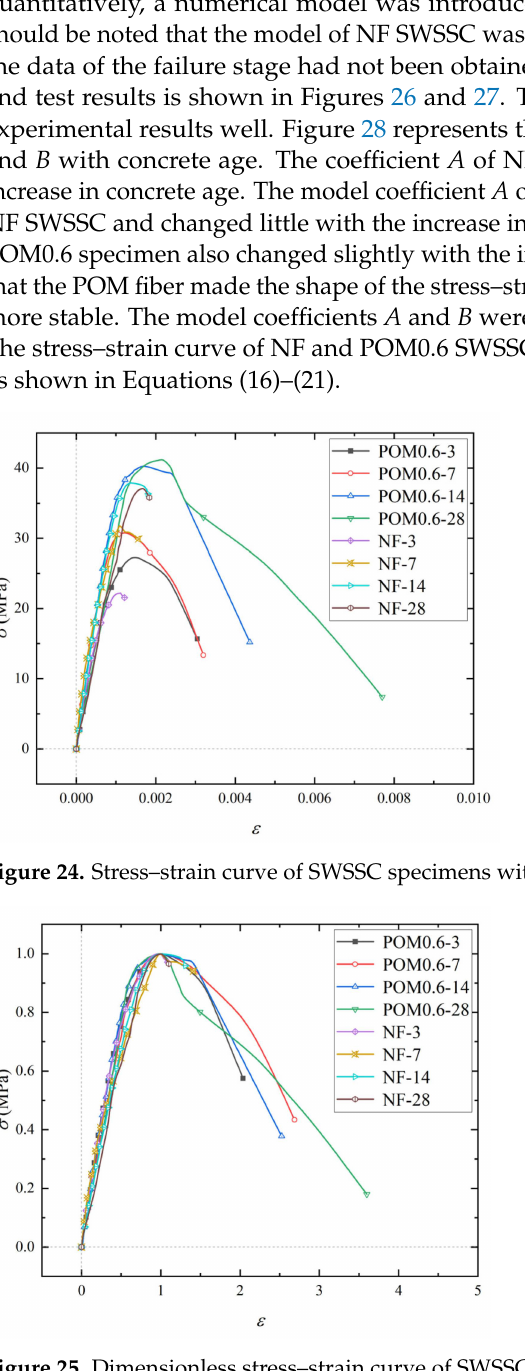
Figure 25. Dimensionless stress–strain curve of SWSSC specimens with different